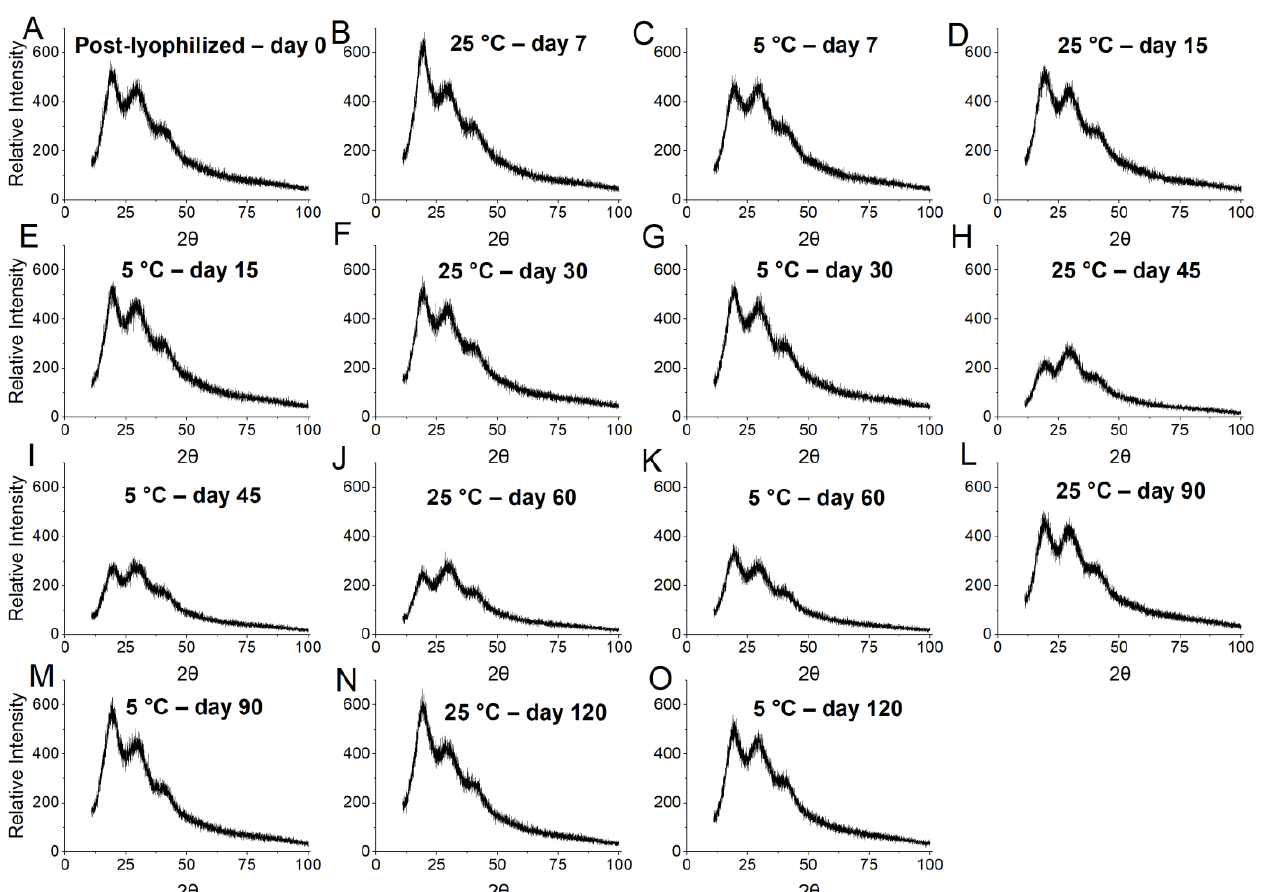
Figure 5. Diffractograms of the gelatin microparticles (LAEG) during storage at different temperatures. ( A ) Post-lyophilized – day 0; ( B ) 25 °C – day 7; ( C ) 5 °C – day 7; ( D ) 25 °C – day 15; ( E ) 5 °C – day 15; ( F ) 25 °C – day 30; ( G ) 5 °C – day 30; ( H ) 25 °C – day 45; ( I ) 5 °C – day 45; ( J ) 25 °C – day 60; ( K ) 5 °C – day 60; ( L ) 25 °C – day 90; ( M ) 5 °C – day 90; ( N ) 25 °C – day 120; ( O ) 5 °C – day 120.